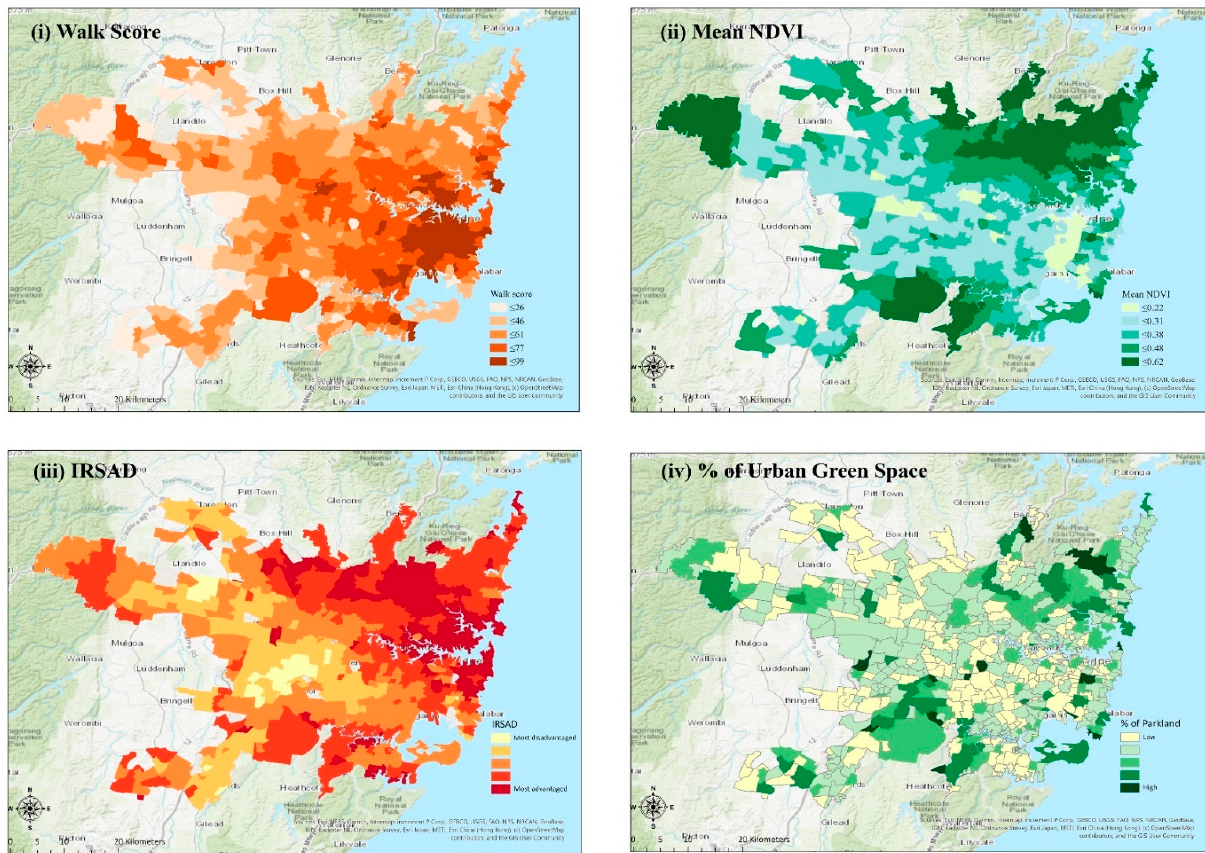
Figure 3. Maps of the main variables examined: ( i ) Walk Score ® , ( ii ) mean NDVI, ( iii ) IRSAD, ( iv )% of urban free space.